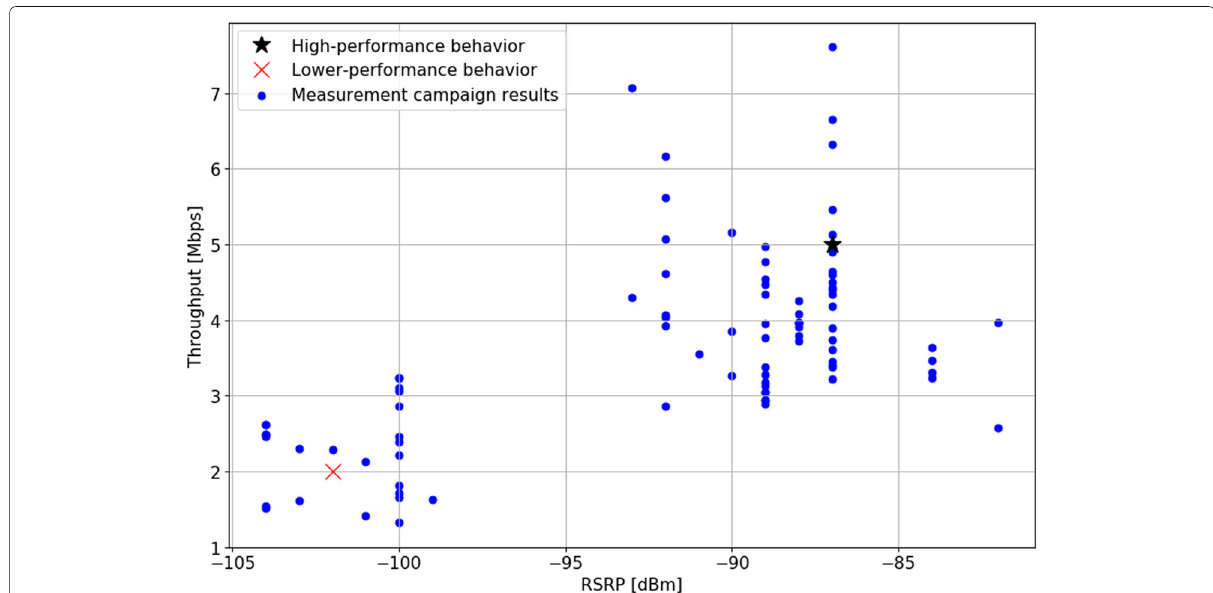
Fig. 7 Classification of measurement campaign results. Centroids representing the average behavior of each cluster are represented with a red cross (low-performance behavior) and a black star (high-performance behavior)